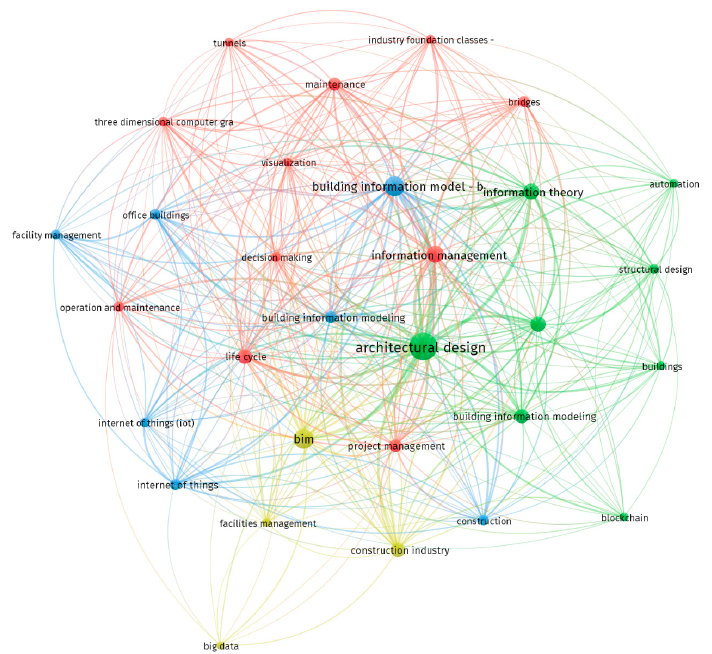
Figure 3. Network of keyword connections of referenced articles. Made with VOSviewer.